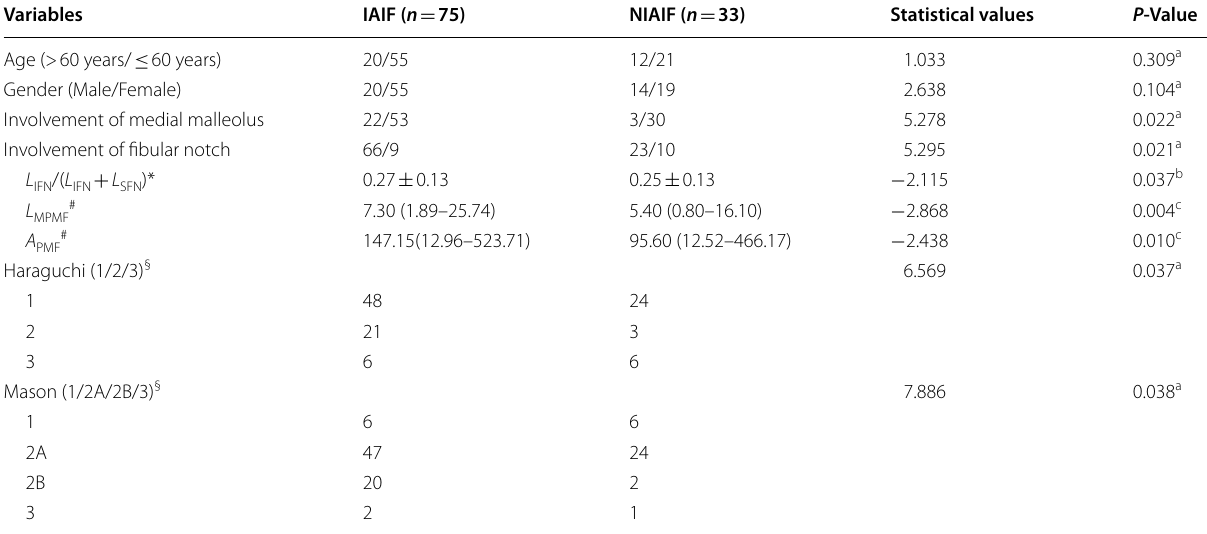
IAIF intraarticular impacted fragments, NIAIF no intraarticular impacted fragments * Values are given as the mean SD ± # Values are given as the median, with the range in